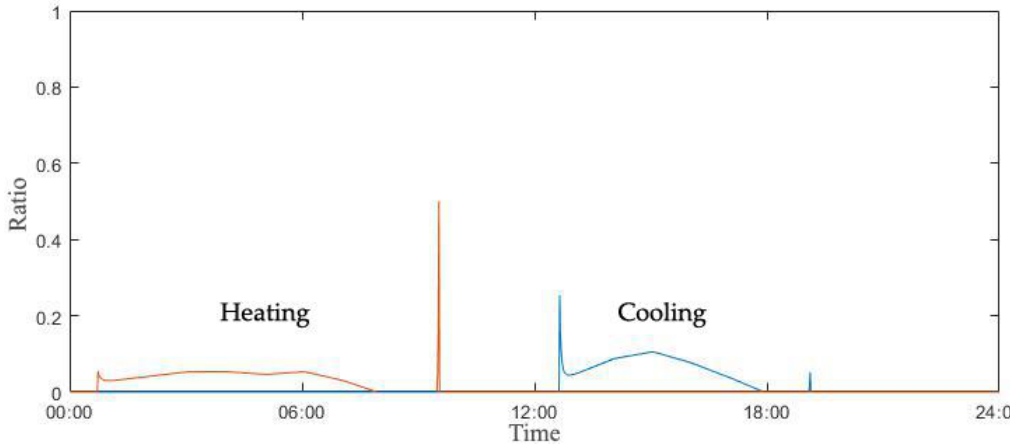
Figure 11. Signals for the amount of supply air by the ANN control.